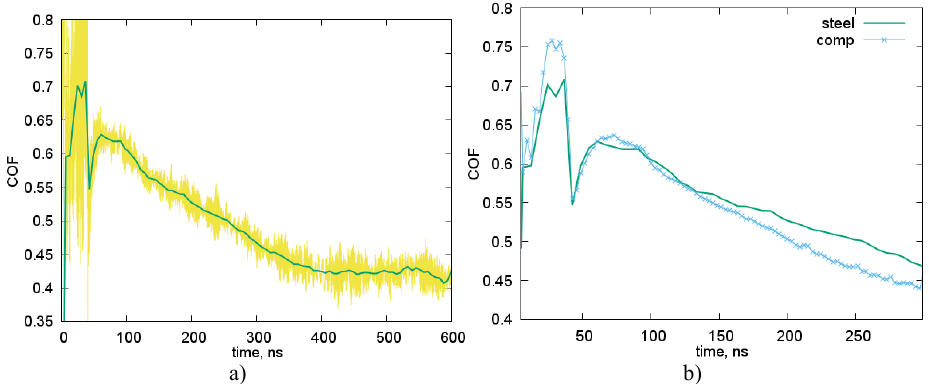
Fig. 5. Coefficient of friction in the model versus calculation time for the steel (a, and b, bold line) and composite bodies (b, line with